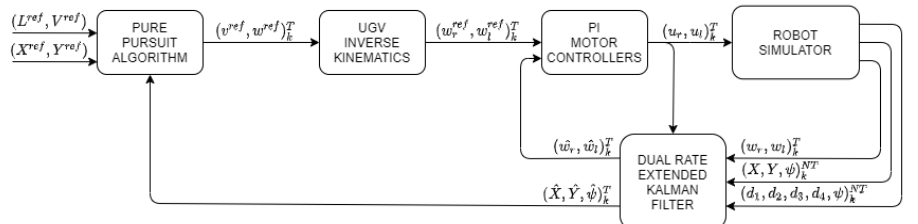
Figure 1. Control structure with DREKF estimator for the